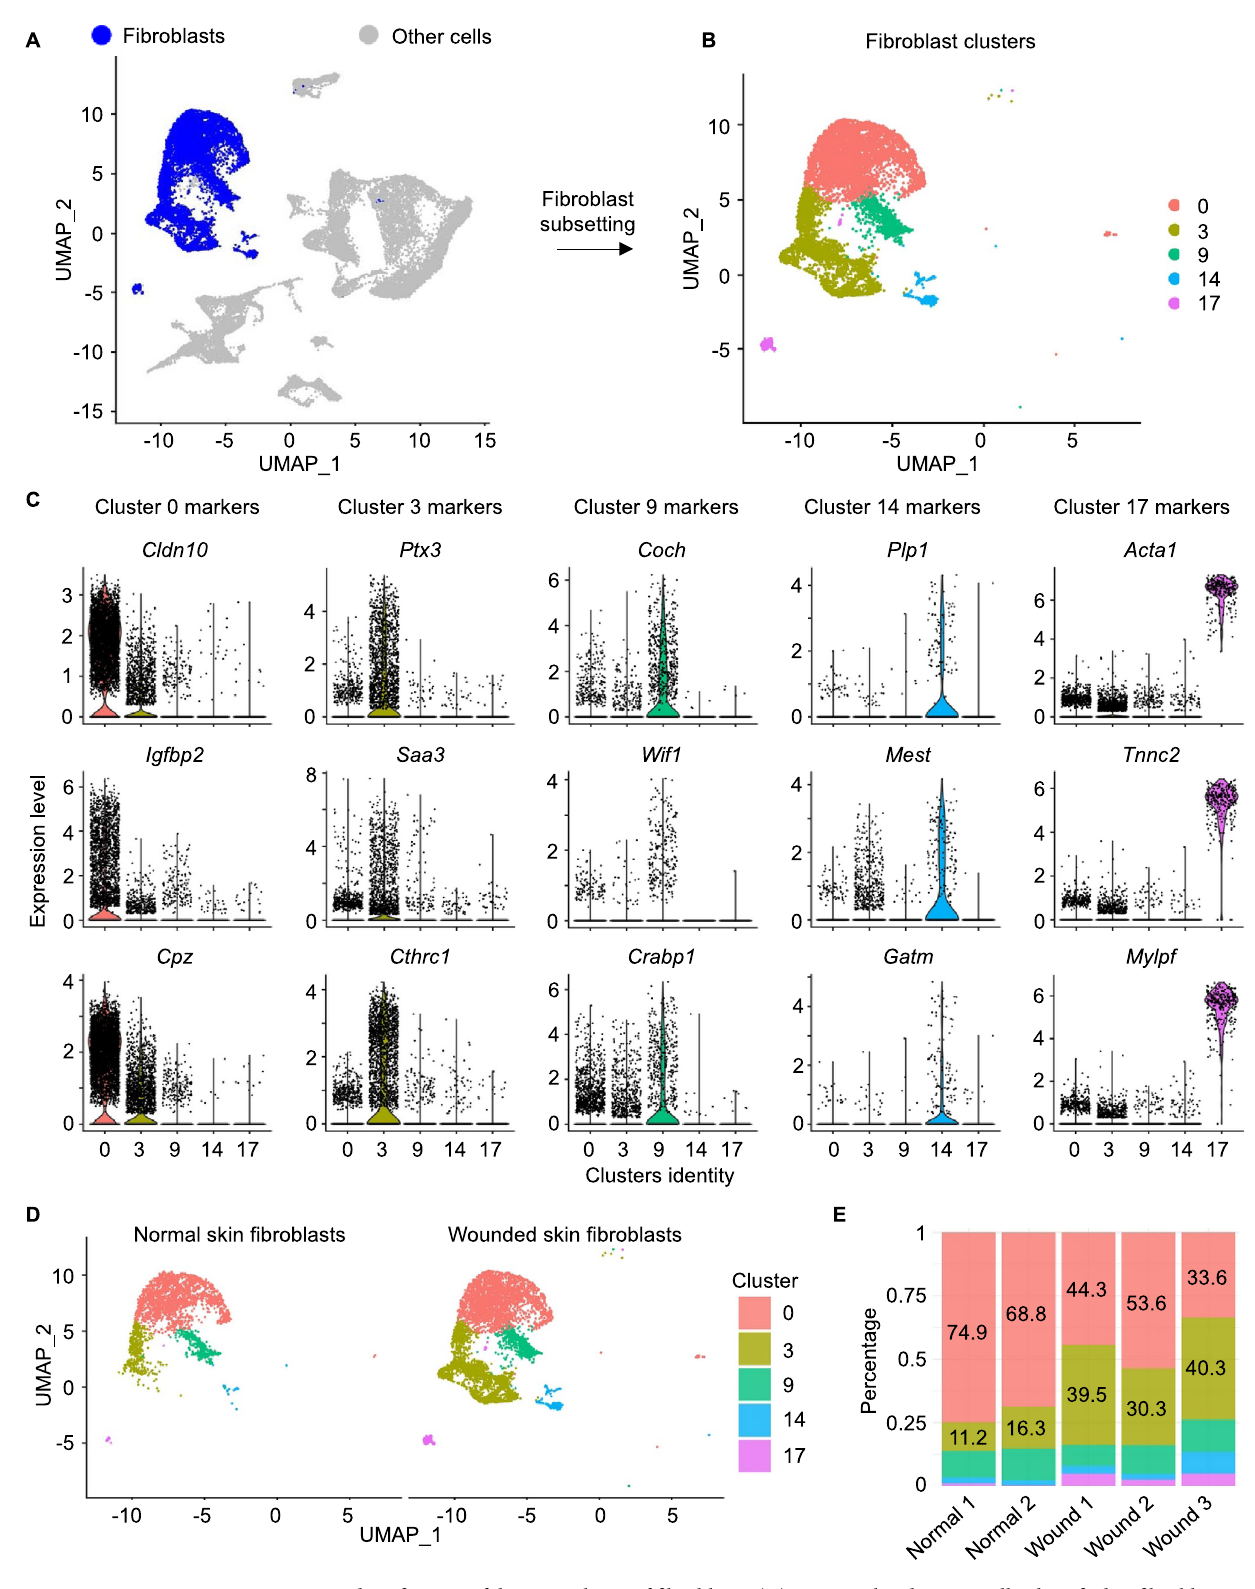
Figure 2. Identification of distinct subsets of fibroblasts. ( A ) UMAP plot showing cells identified as fibroblasts or myofibroblasts in blue color and other cells in grey color. ( B ) Fibroblast clusters. ( C ) Top upregulated 3 genes in fibroblast clusters 0, 3, 9, 14 and 17. ( D ) UMAP plots showing cells identified as fibroblasts splitted by condition (normal skin: left panel and wounded skin: right panel). (E) Barplot representing percentage of each fibroblast cluster among the fibroblast population within each